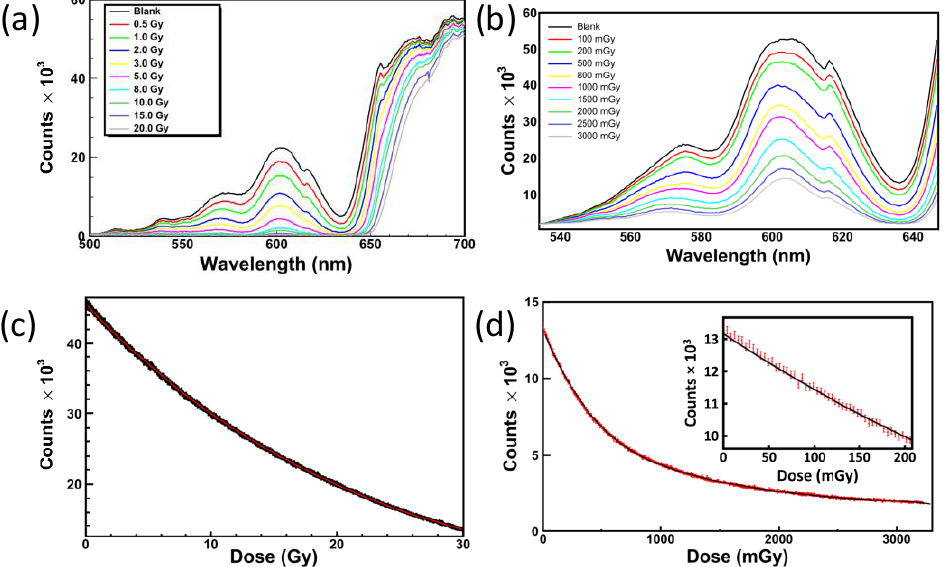
Figure 37. ( a ) Spectra of an EBT3 Gafchromic film exposed to 60 Co γ -rays from the ISOF-CNR High Dose Rate irradiator at Bologna (Italy). ( b ) Spectra of an XR-QA2 Gafchromic film exposed to 60 Co γ -rays from the Low Dose Rate irradiator. ( c ) Calibration of an EBT3 Gafchromic film exposed to 60 Co- γ rays up to 30 Gy; the counts corresponding to the wavelength λ = 663 nm are used for the calibration. ( d ) Calibration of an XR-QA2 Gafchromic film exposed to 60 Co- γ rays at mGy levels; the counts corresponding to the wavelength λ = 635 nm are used for the calibration; the zoom of the main plot in the range of dose [0 – 200 mGy] is shown in the inset. Reproduced with permission from